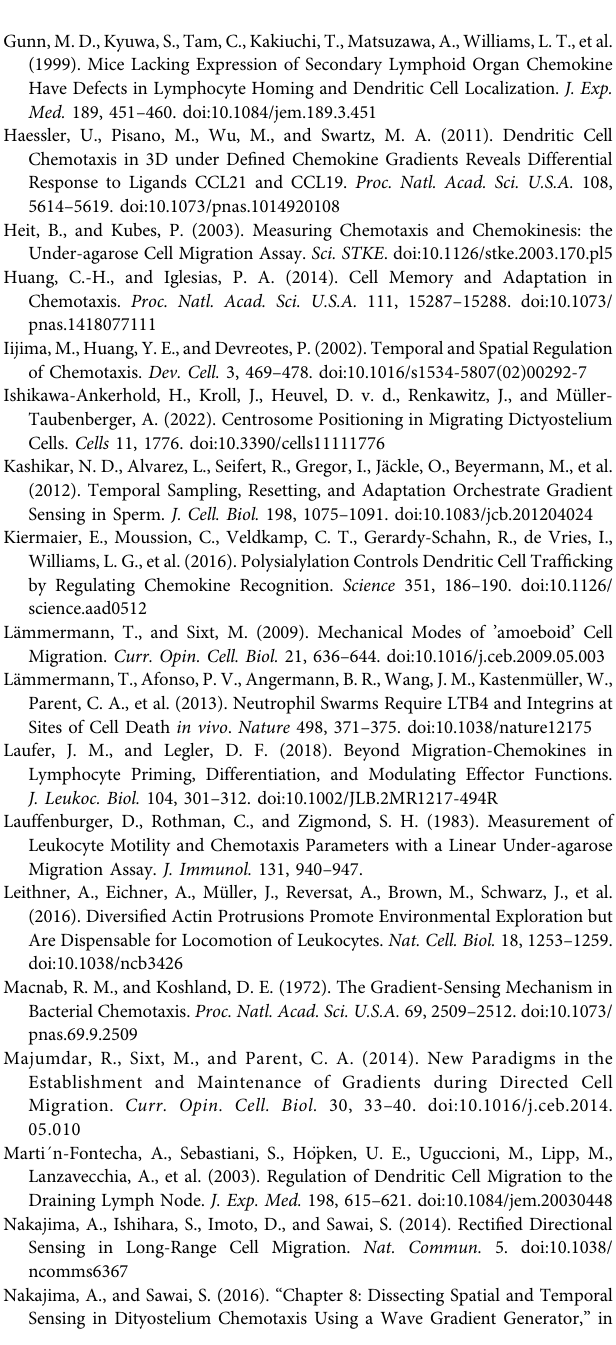
rectify their migration path towards the new established CCL19 gradient. Colored tracks mark trajectories of Lifeact-EGFP expressing BM-DCs (green) towards stable soluble CCL19 tracks following manual tracking (left panel). Corresponding cell trajectories are plotted on the right panel. The gradient is visualized with the help of the surrogate molecule 10 kDa Dextran Alexa Fluor 647 (red). Images were acquired every 2 s. Period of time, 85 min. Supplementary Video S7 | Behavior of Lifeact-EGFP expressing BM-DCs (green) exposed to dynamic traveling CCL19 waves ( τ = 6 min). The bell- shaped waves are visualized with the help of the surrogate molecule 10 kDa Dextran Alexa Fluor 647 (red). Images were acquired every 2 s. Period of time, 50